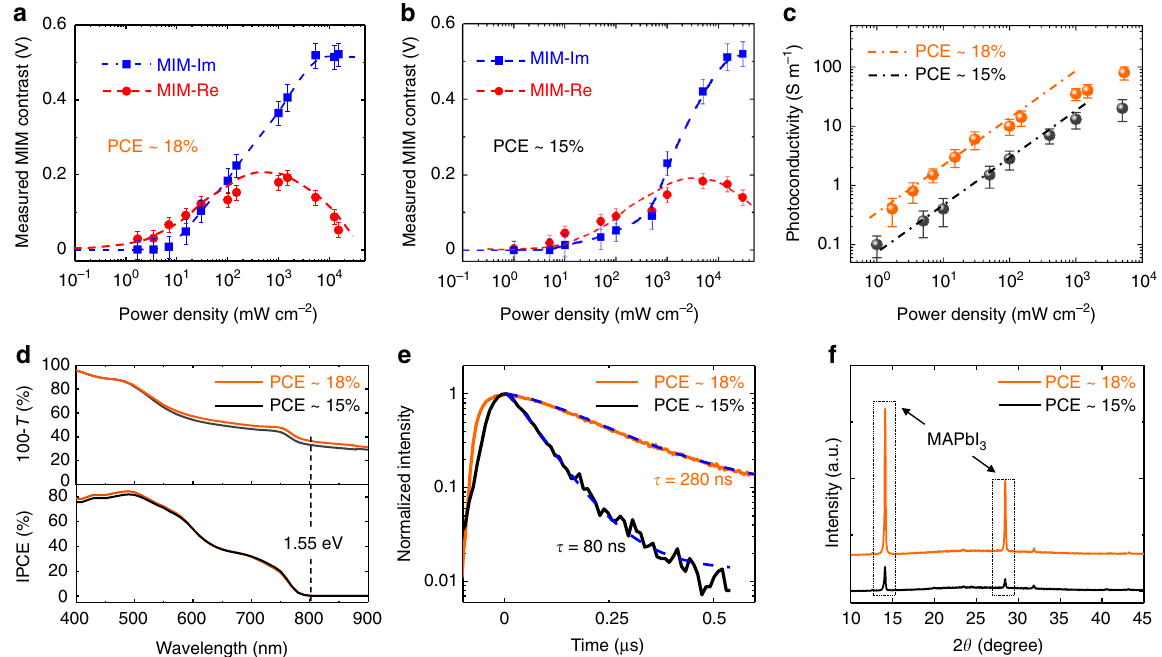
Fig. 3 Photoconductivity and other characterizations of MAPbI 3 thin fi lms. a Measured MIM signals of the PCE around 18% and b 15% samples (with respect to the values without light) as a function of the incident 532 nm-laser power. The raw data of a and b are shown in Supplementary Fig. 5. The error bars are estimated from the standard deviation of the raw MIM data. c Photoconductivity of both samples extracted from the experimental data vs. the laser intensity. The dash-dotted lines are linear fi ts for laser power below 100 mW cm − 2 . d Optical absorptivity (upper panel) and IPCE (low panel) spectra of the perovskite thin fi lms with 18% and 15% PCE. The optical gap of MAPbI 3 is indicated in the plots. e TRPL measurements of the two samples, from which the carrier lifetime can be extracted. The excitation power in the TRPL measurements is around 30 mW cm − 2 , which is within the linear regime of the MIM data in c . f XRD measurements of the two samples, indicating a much higher crystallinity of the 18% PCE